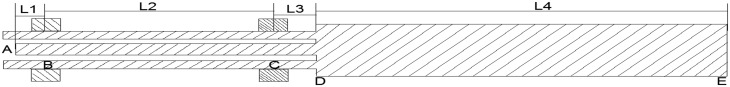
Simplified structure of fin-shaft.